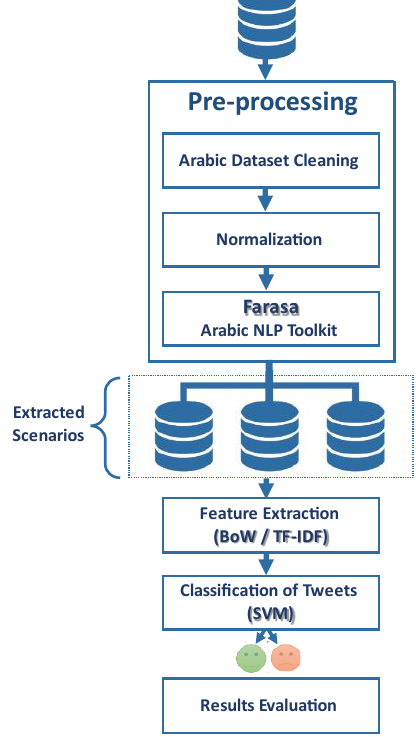
Figure 2. Cyberbullying detection in Arabic using SVM.